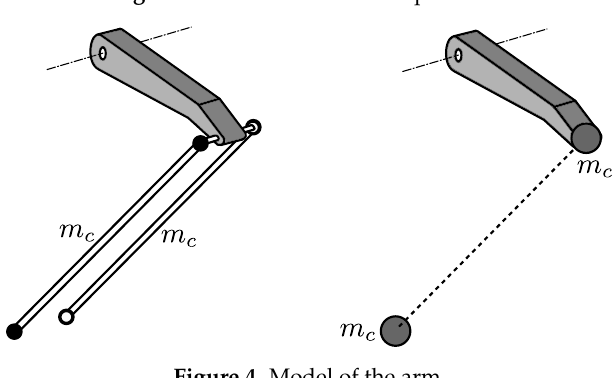
Figure 4. Model of the